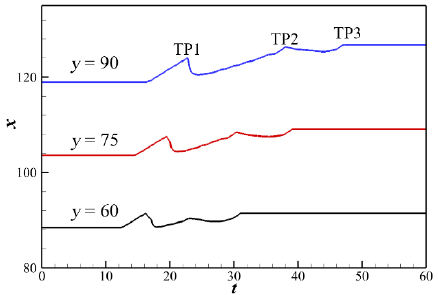
Figure 6. Shock-front positions along the lines y = 60, 75, and 90 when M 0 increases from 5.5 to 6.0. The structural variation of decreasing M 0 is shown in Figure 7. Initially, an ODW with M 0 6.0 exists, whose structure features a postcorner recirculation zone. Then, the inflow M 0 of the left boundary changes from 6.0 to 5.5, and the flow time is reset to zero simultaneously. Similarly, M 0 variation also leads to a distortional wave surface, gener- ating two TPs. TP1 also originated from the interaction of the velocity contact and deto- nation front, however, the movement of the resulting TP1 is slightly slower than the con- tact surface. Notably, when the contact surface goes through the whole flow fields, TP2 still exists on the surface, which has a slow-moving process to adjust the wave surface. During this process, the recirculation zone becomes smaller but does not disappear until t = 70.09 (Figure 7f).